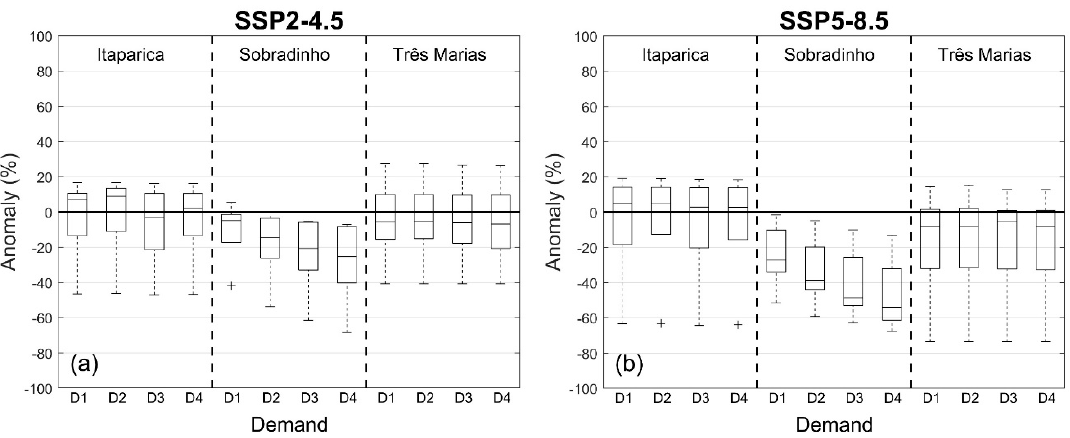
Figure 15. Annual percentage anomaly of the Energies of Itaparica, Sobradinho and Três Marias HPP obtained with the SIGA software with the projections of the consumptive demands D1, D2, D3 and D4 with the scenario: ( a ) SSP2-4.5 and ( b ) SSP5-8.5 in the period from 2021 to 2050 referring to the historical period from 1901 to 2000.